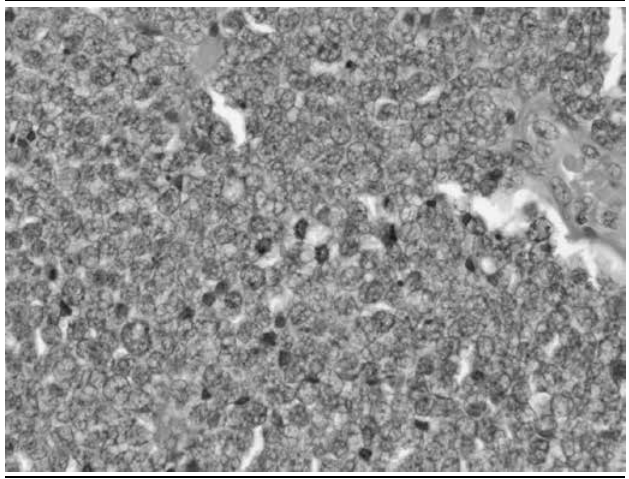
figurE 1 – Photomicrograph of MCC, formed by cells with round homogeneous nuclei, scant cytoplasm, and numerous mitotic figures. HE, 400× MCC: Merkel cell carcinoma; HE: hematoxylin and eosin. Immunohistochemical staining was positive for cytokeratin